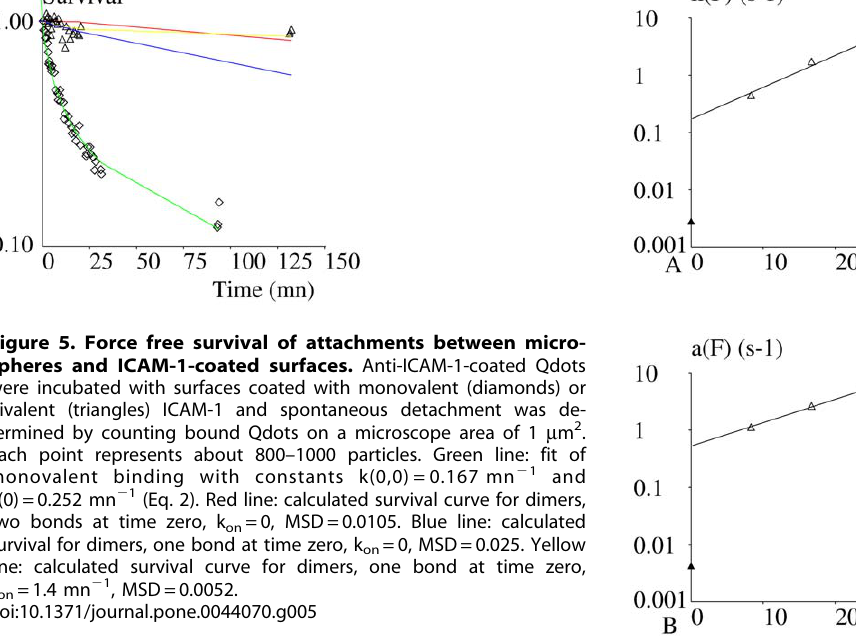
Table 1. Estimated parameters for rupture of ICAM-1/anti-ICAM-1 bonds subjected to force.